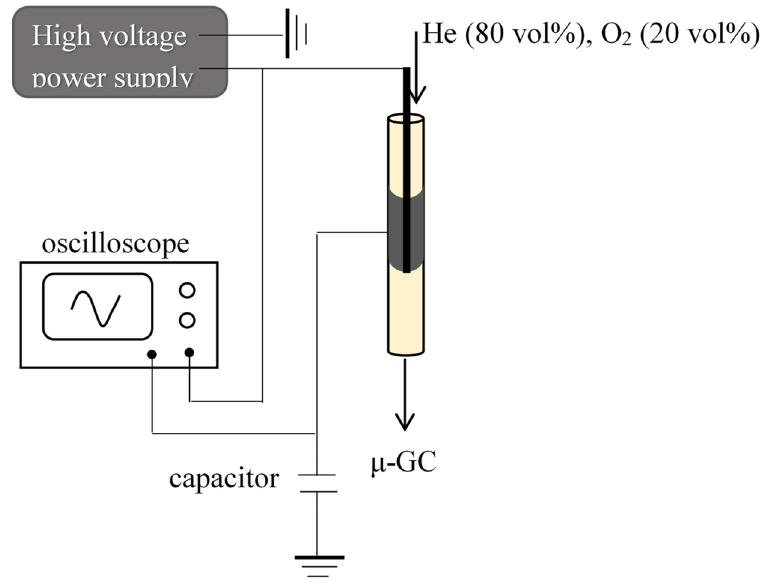
Figure 10. Dielectric barrier discharge plasma reactor.